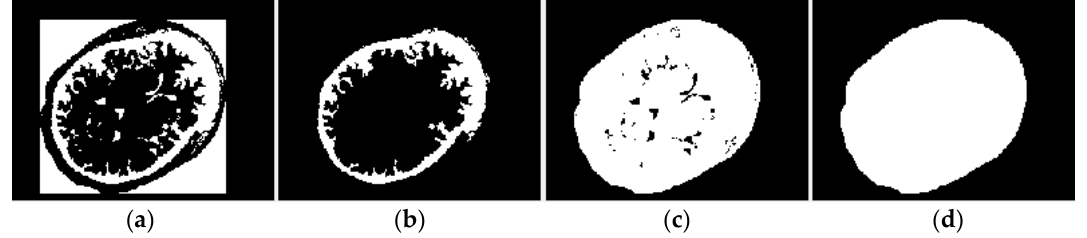
Figure 3. Intermediate steps between images I 3 and I 4 , ( a ) logical AND of I 2 with the rectangular boundary, ( b ) largest connected component, ( c ) logical OR of ( b ) with I 3 , ( d ) holes filling using morphological flood-fill operation .